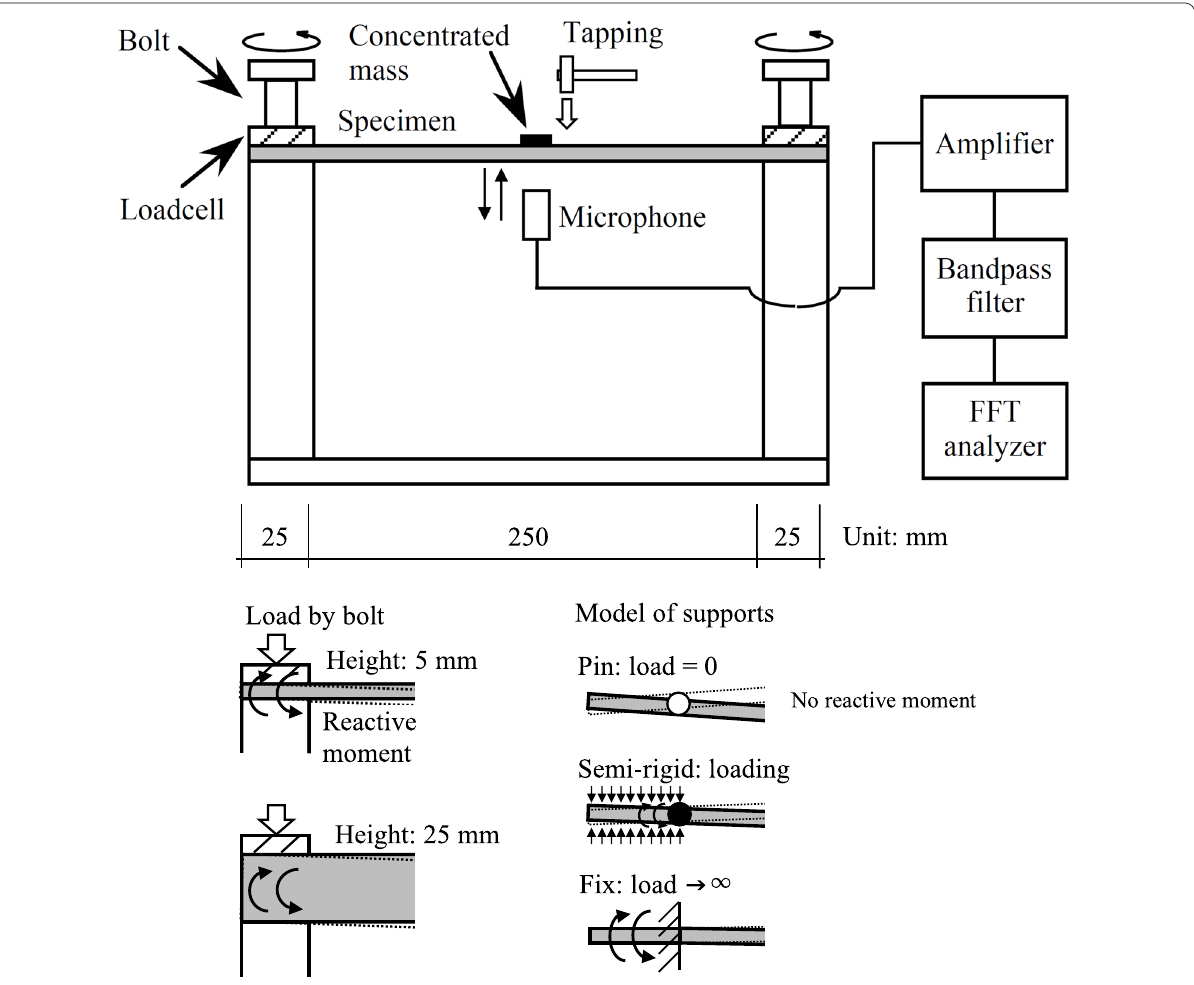
Fig. 3 Schematic diagram of the experimental setup for the bending vibration test under various end